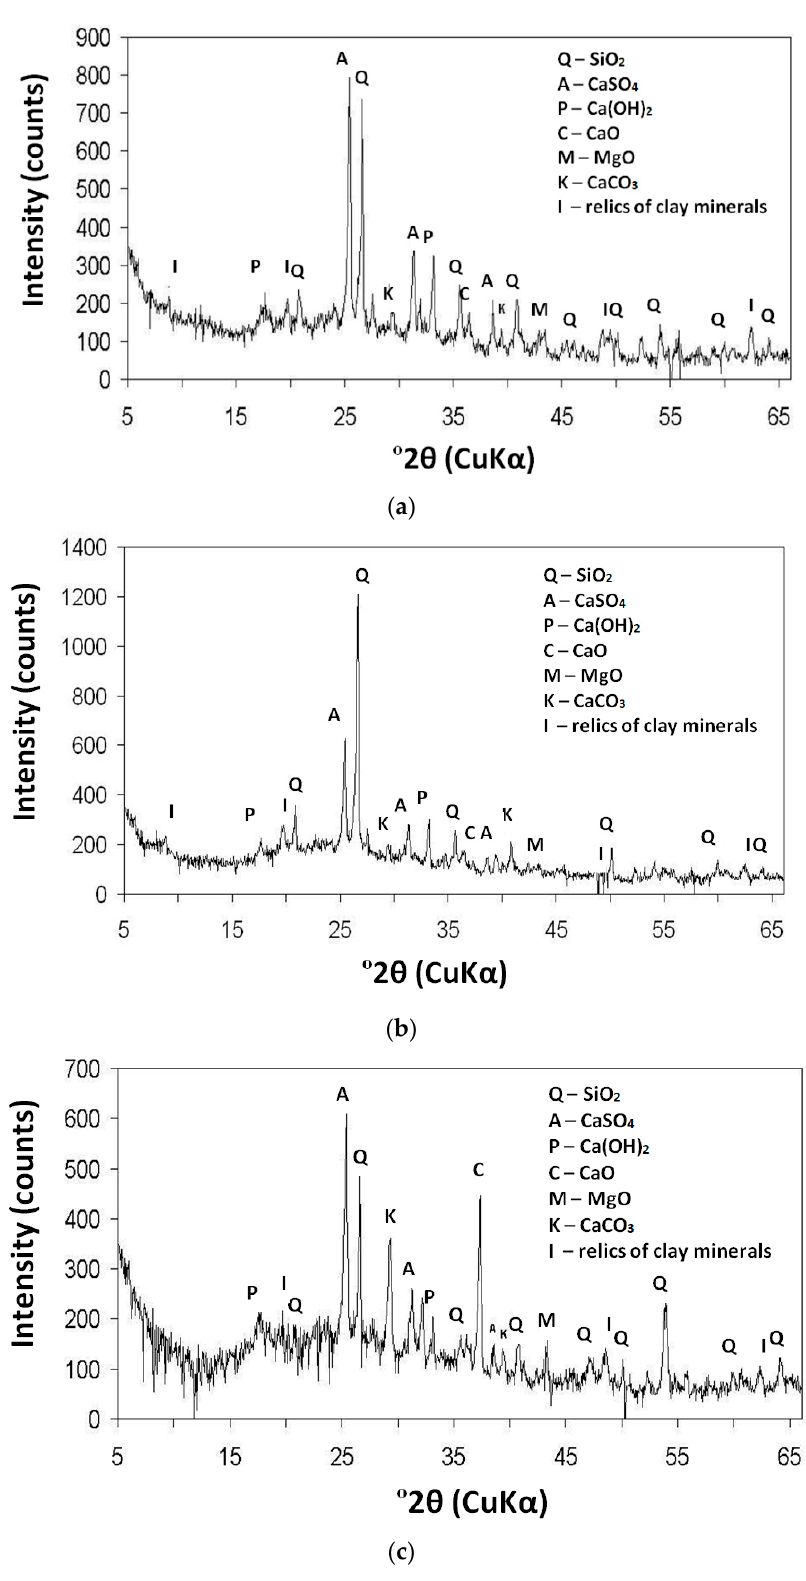
Figure 3. X-ray (XRD) patterns of CFBC fly ash from ( a ) S (hard coal); ( b ) K (hard coal); and ( c ) T (lignite).